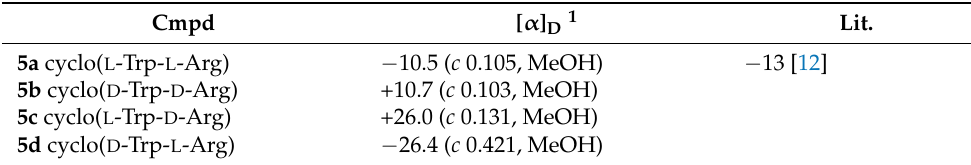
Table 1. Specific rotation values observed for diketopiperazines 5a–d .